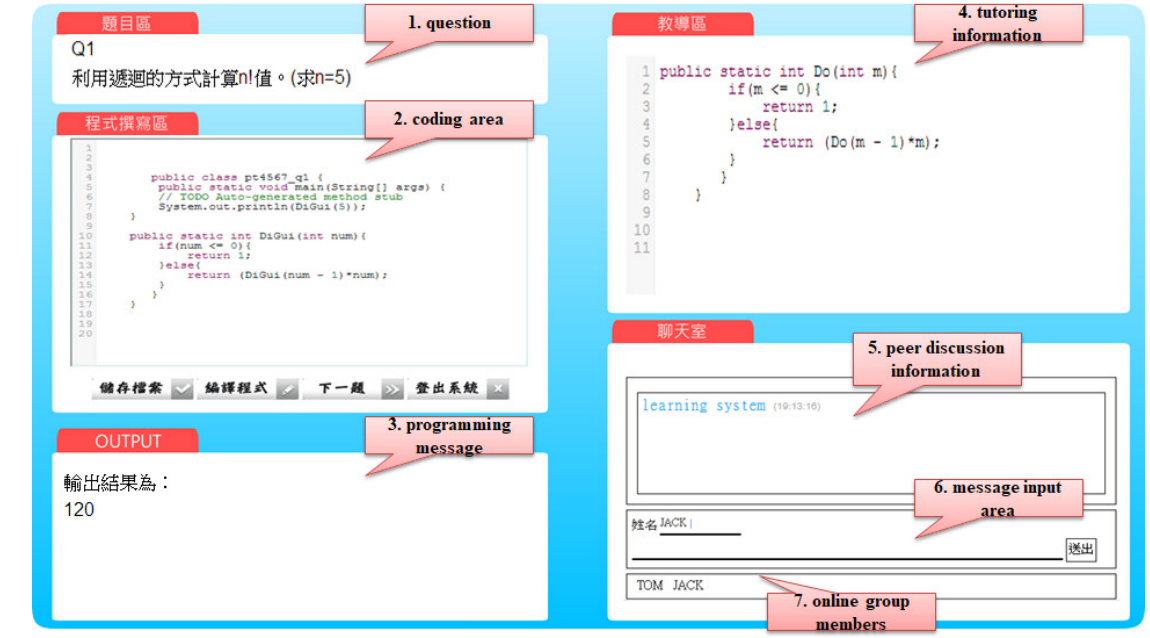
Figure 2. System frame − Experimental group A (tutee).